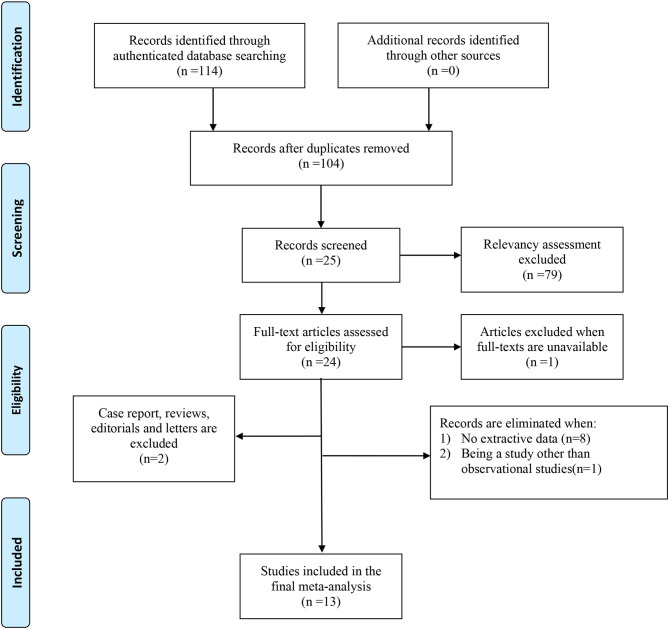
PRISMA 2009 flow diagram. From Moher et al. (25). For more information, visit www.prisma-statement.org.